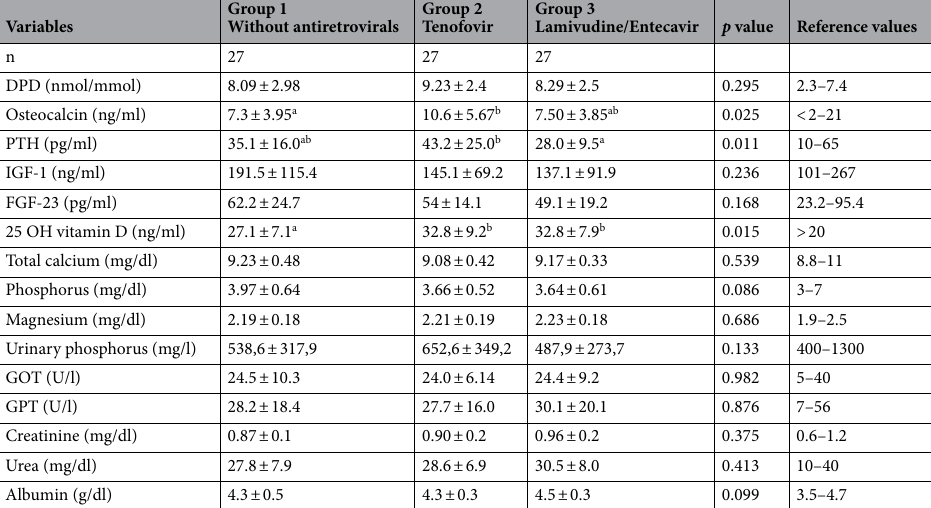
Table 2. Serum and urinary biochemical parameters of patients with chronic hepatitis B virus infection in use or not of antiretrovirals. ANOVA one way. Values are expressed as mean ± standard deviation. Different letters p ≤ 0.05. DPD, deoxypyridinoline; PTH, parathormone; IGF-1, insulin-like growth factor-1; FGF-23, fibroblast growth factor 23; GOT, glutamic-oxaloacetic transaminase; GPT, glutamic-pyruvic transaminase. FGF-23 n = 16–17 per